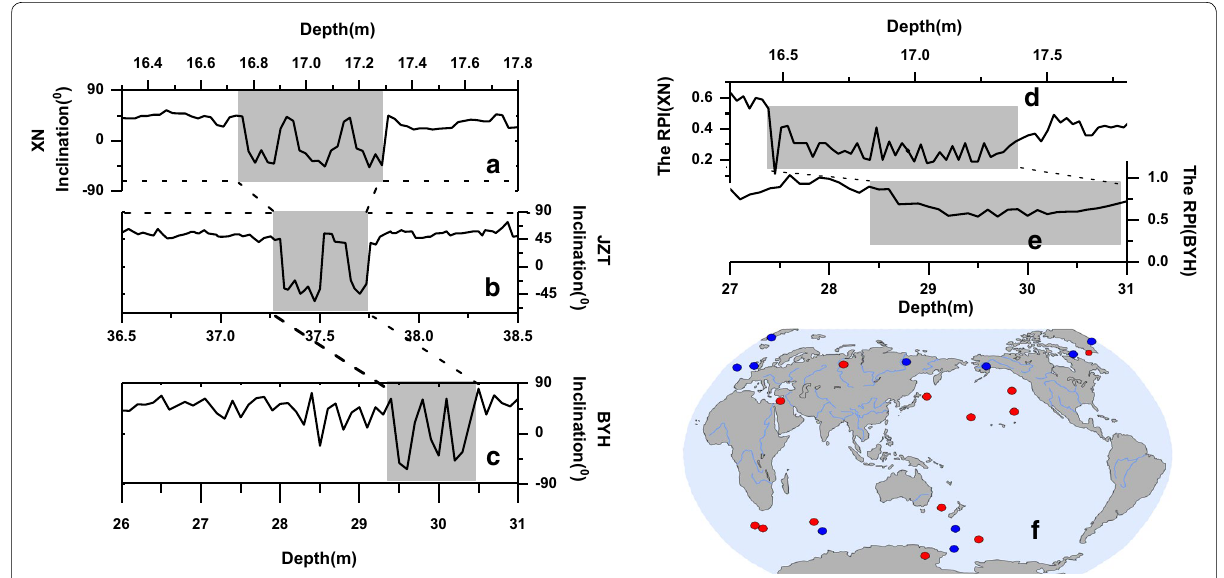
Fig. 9 Comparison of inclination record in the BYH section ( c ) with Xining ( a ) (XN, Zhu et al.1994) and Jiuzhoutai ( b ) (JZT, Fang et al. 1997) sections. The RPI record comparison between the Xining section ( d ) and the BYH section ( e ) (Zhu et al. 1994). f Virtual geomagnetic poles (VGPs) for the depth interval (9.1–9.9 m and 29.2–30.4 m) that contains the BGE (red) and LGE (blue), respectively, in the BYH